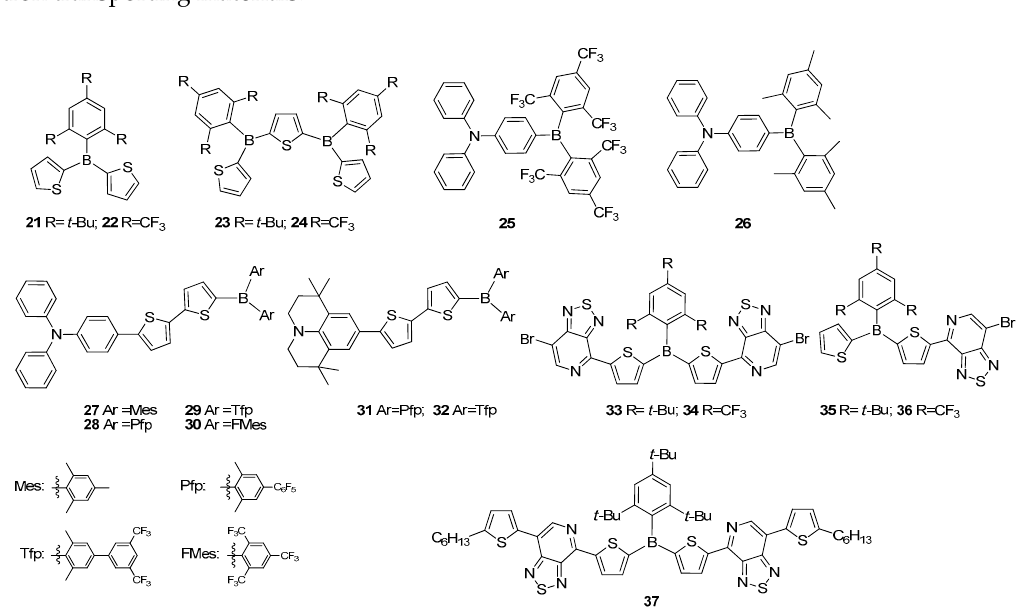
Figure 7. Triarylborane-based materials 21 – 37 .